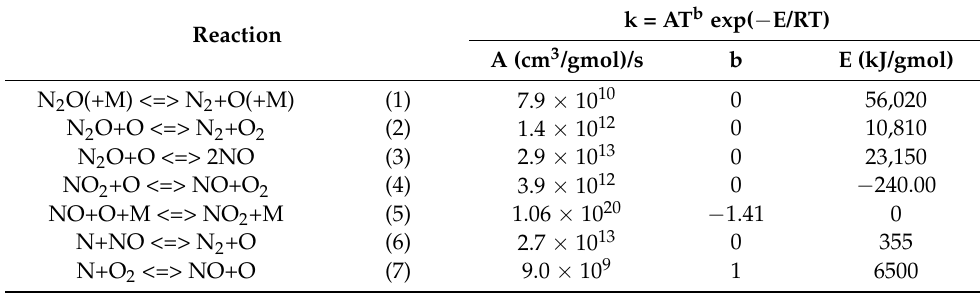
Table 3. GRI-Mech